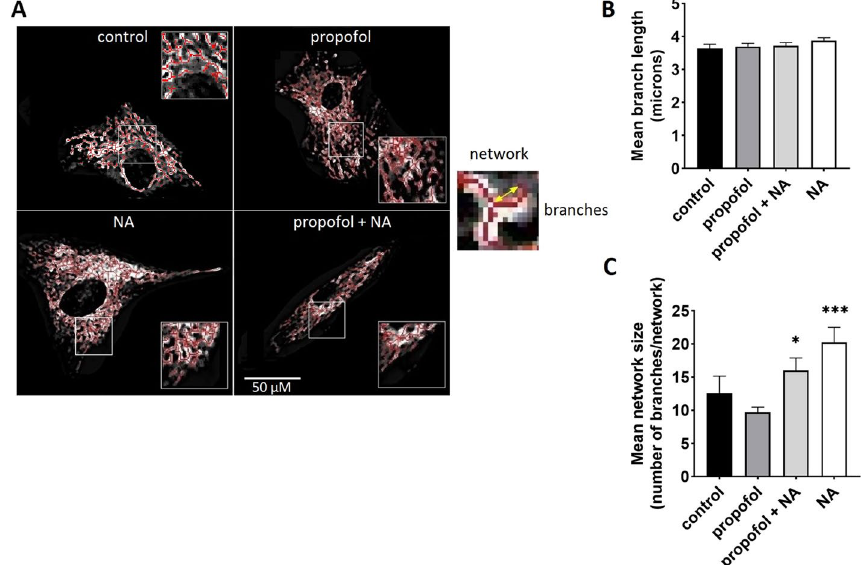
Fig. 3 Mitochondrial morphology. Confocal images of myoblasts stained with MitoTracker ™ Green FM analysed with the ImageJ ™ plugin “MINA”. A Representative skeletonized images show mitochondrial network in different groups (left). Measurements were performed at least at 50 cells per each group from 3 independent experiments ( 3 individual subjects). Yellow arrow (right) shows one of the three branches in = an example of mitochondrial network. B and C Mean branch length and mean network size ( branches per network) were analysed in each cell separately. Error bars indicate standard error of the mean. * p < 0.05, *** p < 0.001 vs. control group. NA